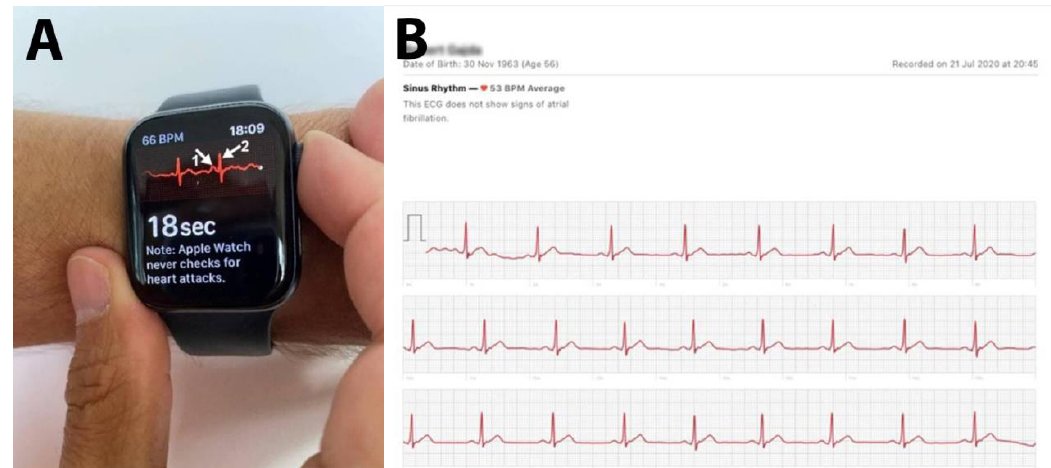
Figure 3. ECG on the Apple Watch, iPhone. ( A ) On the screen, a temporary ECG trace with the morphology of the II limb lead of a classic ECG is shown. Visible: HR 66 bpm. Visible P-waves (arrow 1) and QRS complexes (arrow 2). ( B ) ECG record sent to the iPhone; image taken from the phone screen. Touching the Apple Watch Series 4 Digital Crown completes the circuit and measures electrical signals across the heart.